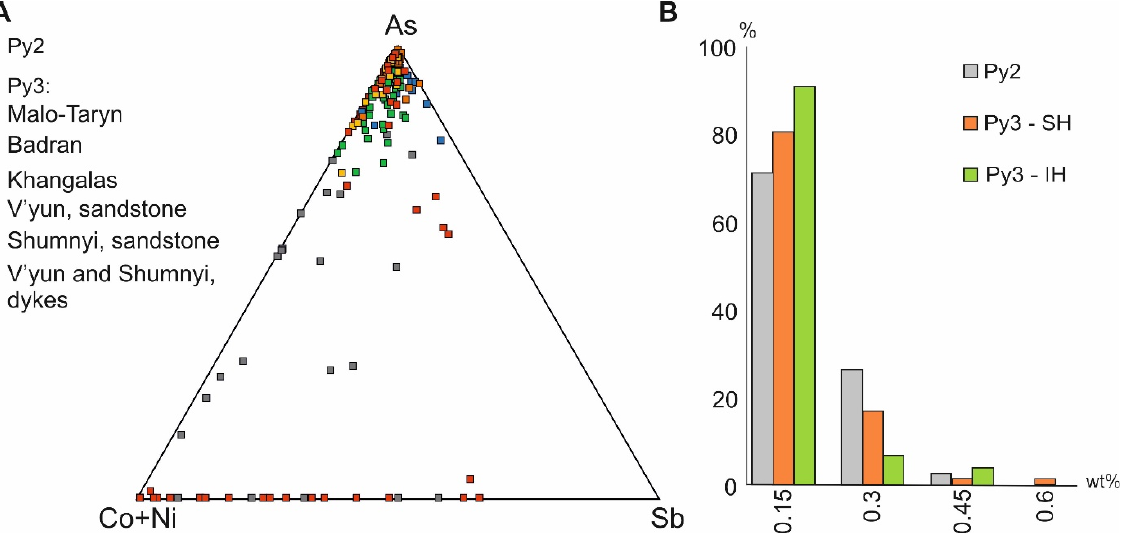
Figure 11. Distribution of trace elements in pyrites of different generations in the studied OGDs, central YKMB: ( A ) ternary diagram As–Co+Ni–Sb for Py2 and Py3; ( B ) content of Σ (Co, Ni, Cu, Sb, Pb).